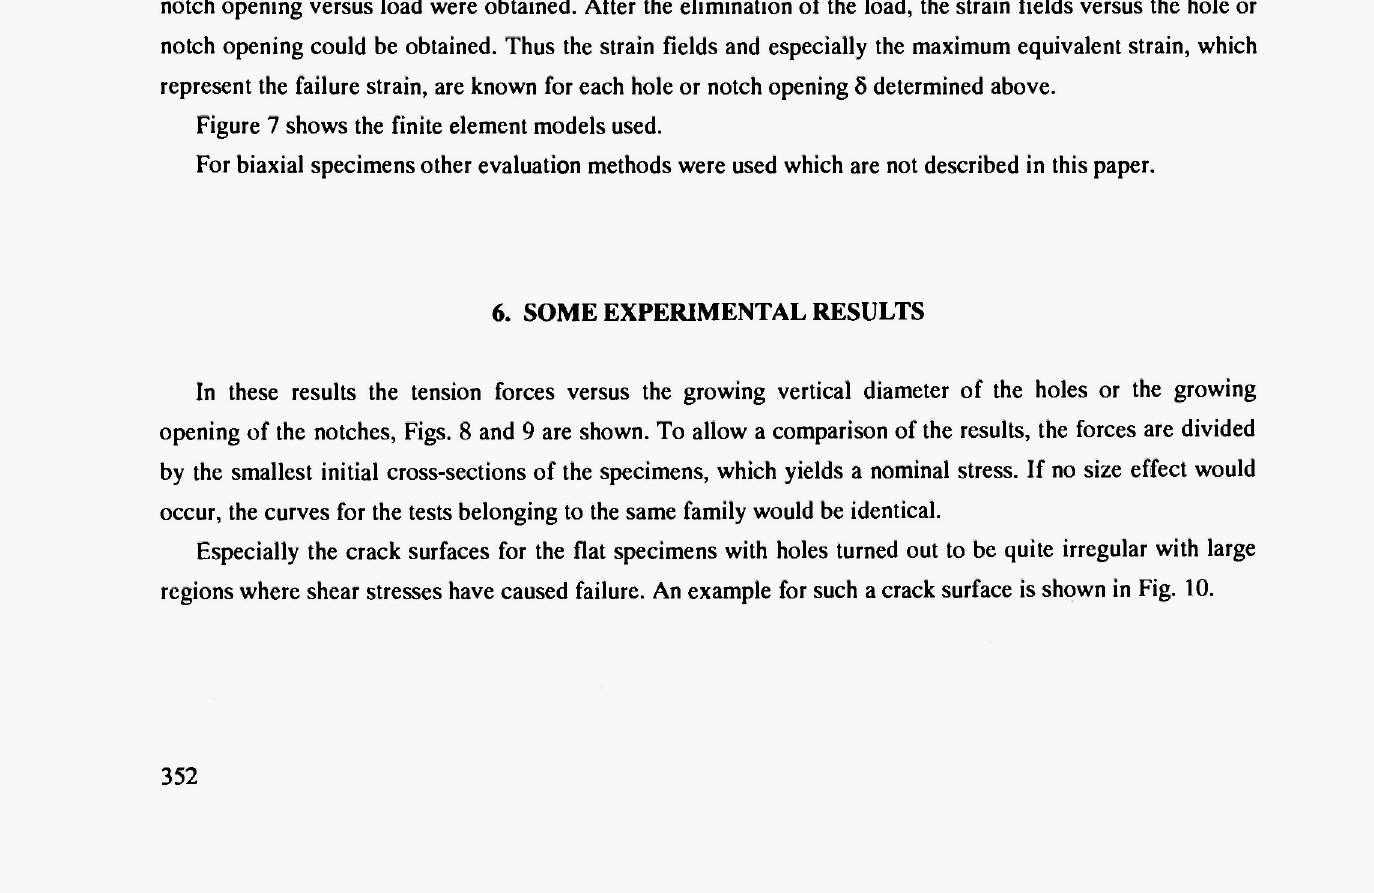
As indicated above, the relative hole or notch opening δ was used to reconstruct the complete strain fields in the specimen. For each family of tension tests one specimen was selected, the tension force increased monotonically step-by-step and finite element calculations were carried out for each step. To describe the material properties elastic-plastic stress-strain diagrams were used. Both, the strain fields and the hole or notch opening versus load were obtained. After the elimination of the load, the strain fields versus the hole or notch opening could be obtained. Thus the strain fields and especially the maximum equivalent strain, which represent the failure strain, are known for each hole or notch opening δ determined